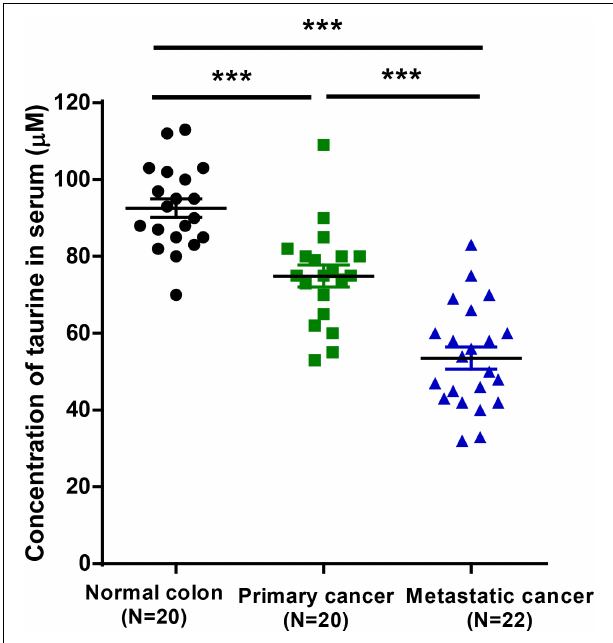
FIGURE 9 | Downregulated taurine levels in serum are correlated with a poor prognosis in CRC patients (mean ± SEM) ( N = 20 normal and 42 patients; one-way ANOVA followed by Tukey’s post hoc test, *** P < 0.001).